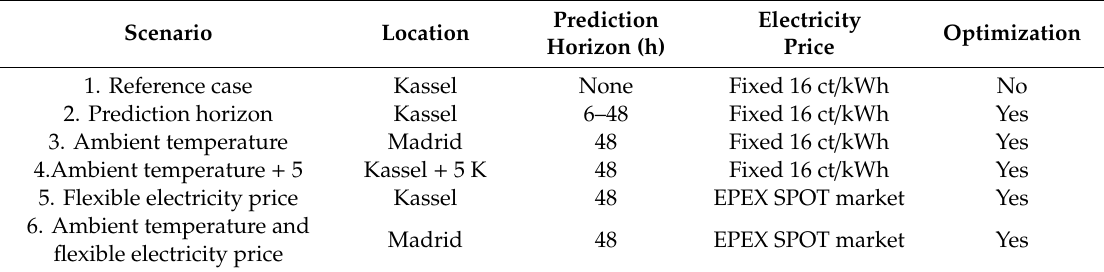
Table 2. Overview of simulated scenarios and parameters.